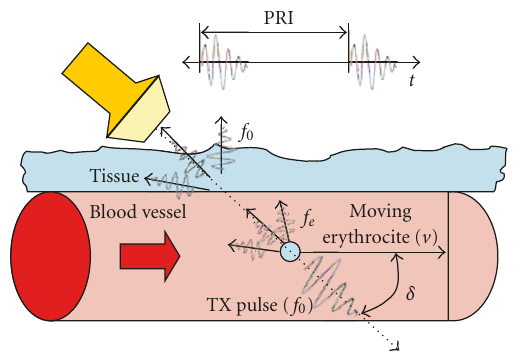
Figure 1: In PW Doppler investigations, an US pulse is transmitted into tissues during each PRI, causing echoes travelling back to the transducer carrying information about tissue interfaces and moving particles.